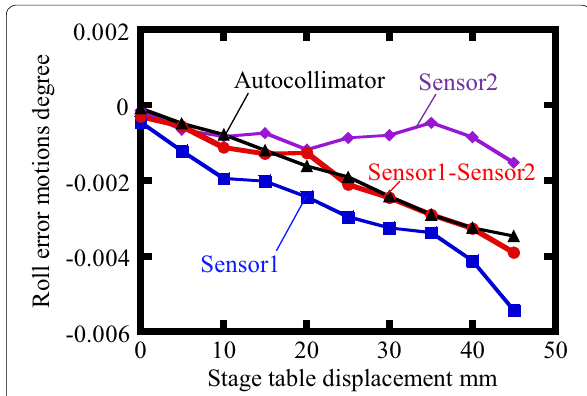
Figure 13 Roll error motion measured by the developed